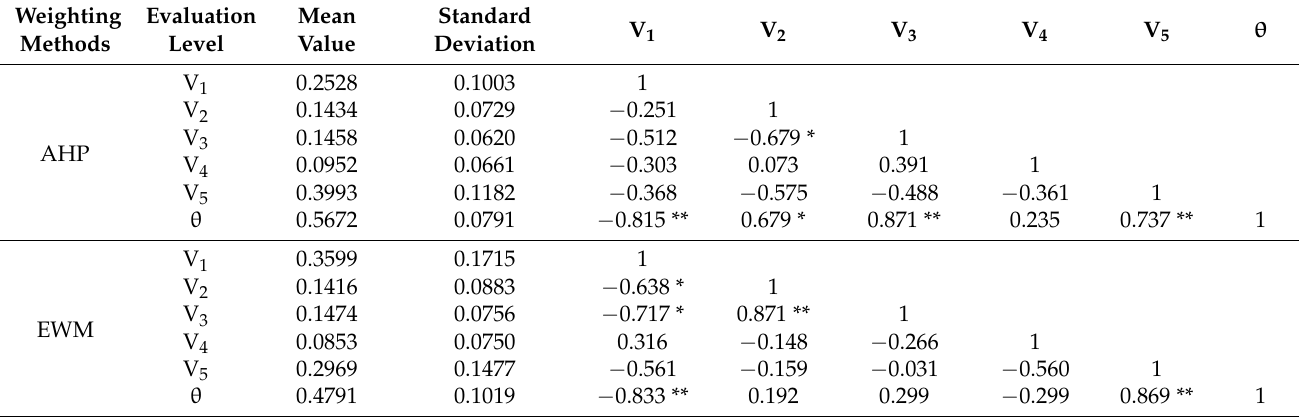
Table 5. Correlation analysis of the membership values of two weighting methods and evaluation